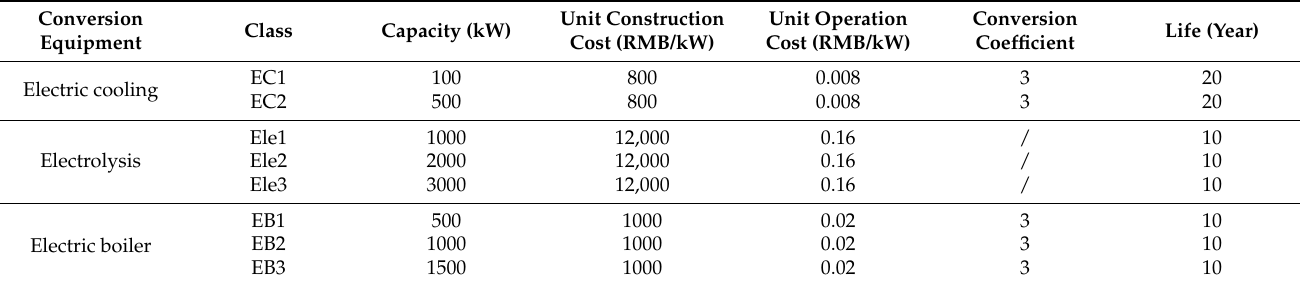
Table 1. Parameters of candidate conversion equipment in DES 0.